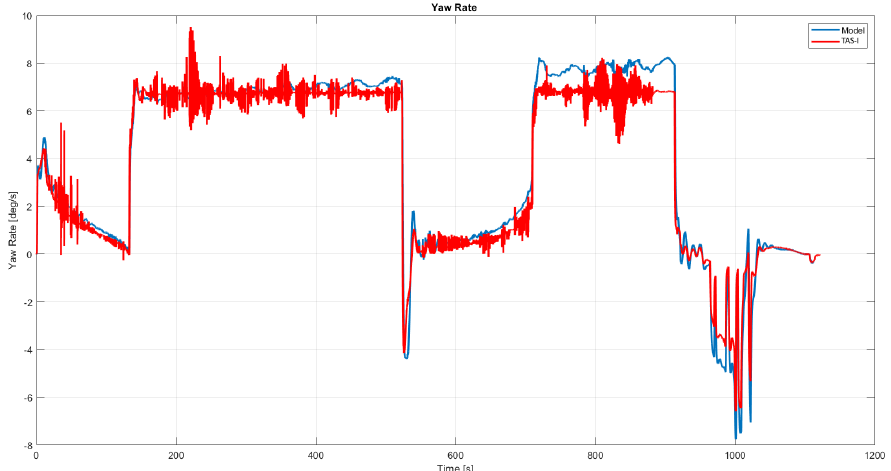
Figure 11. Yaw rate comparison with the TAS − I drop test